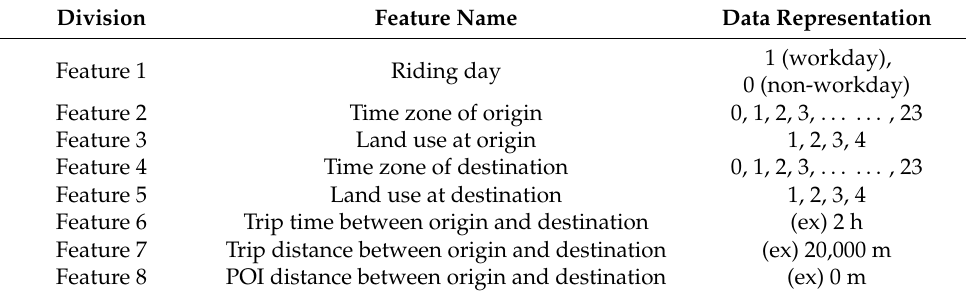
Table 7. Feature selection for bike trip purpose inference.